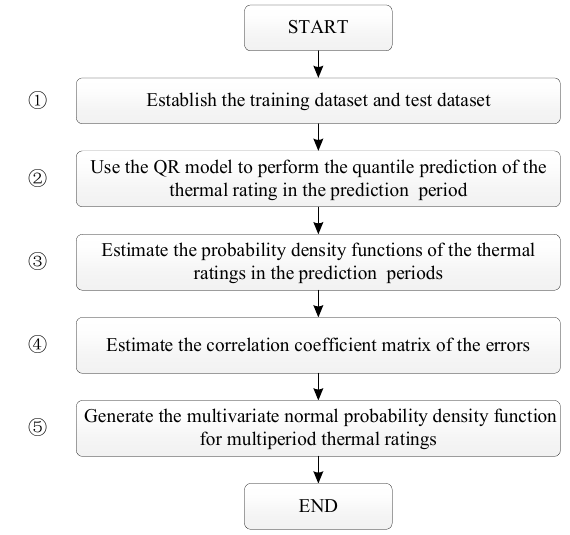
Fig. 3. Flowchart of the prediction